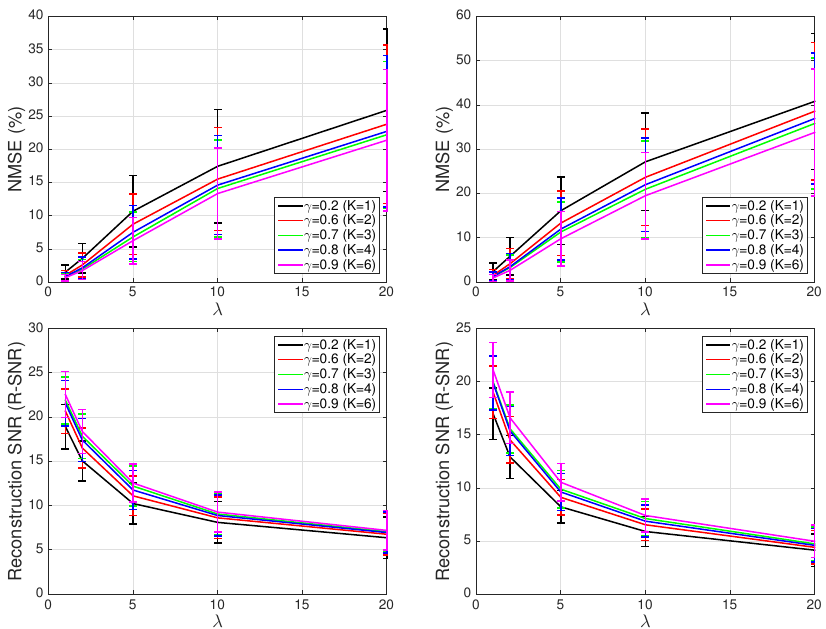
Figure 10. Different performance metrics: ( Left ) results on signals from training set; and ( Right ) results on signals from test set (i.e., signals not used to build the dictionary).